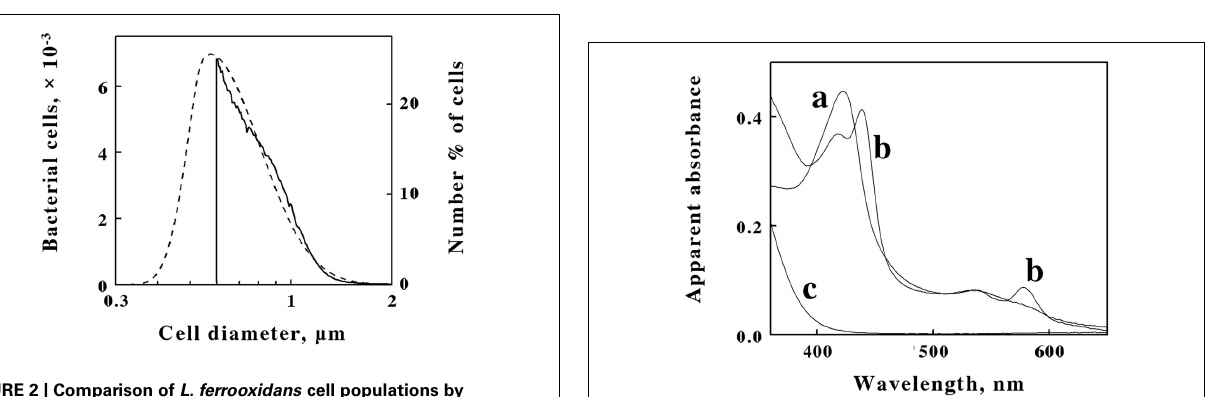
FIGURE 2 | Comparison of L. ferrooxidans cell populations by electrical impedance (solid line) and static light diffraction methods (dashed line). Electrical impedance measurements yielded absolute numbers of cells (left ordinate) as a function of size; light diffraction measurements yielded relative numbers of cells (right ordinate) as a function of size.The scale of each ordinate was chosen to facilitate comparison of the curves.The area under the electrical impedance curve was 81.2% of that under the light diffraction curve.